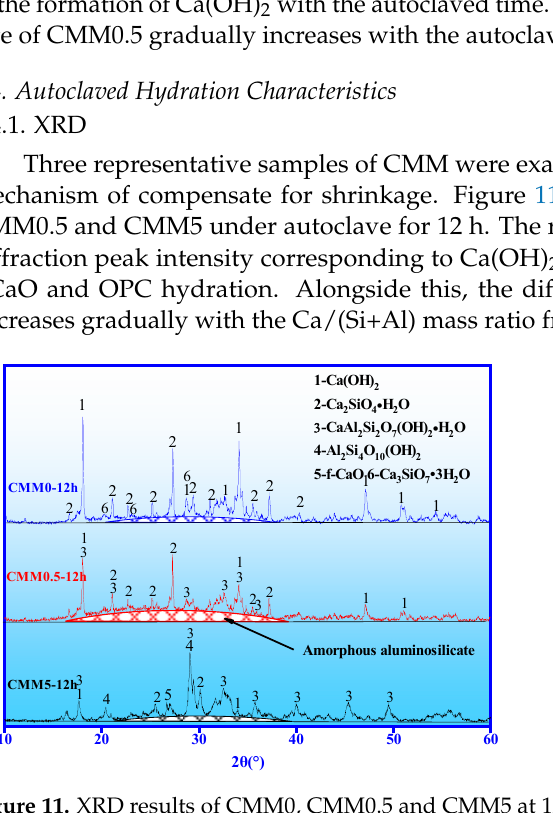
Figure 11. XRD results of CMM0, CMM0.5 and CMM5 at 12 h.